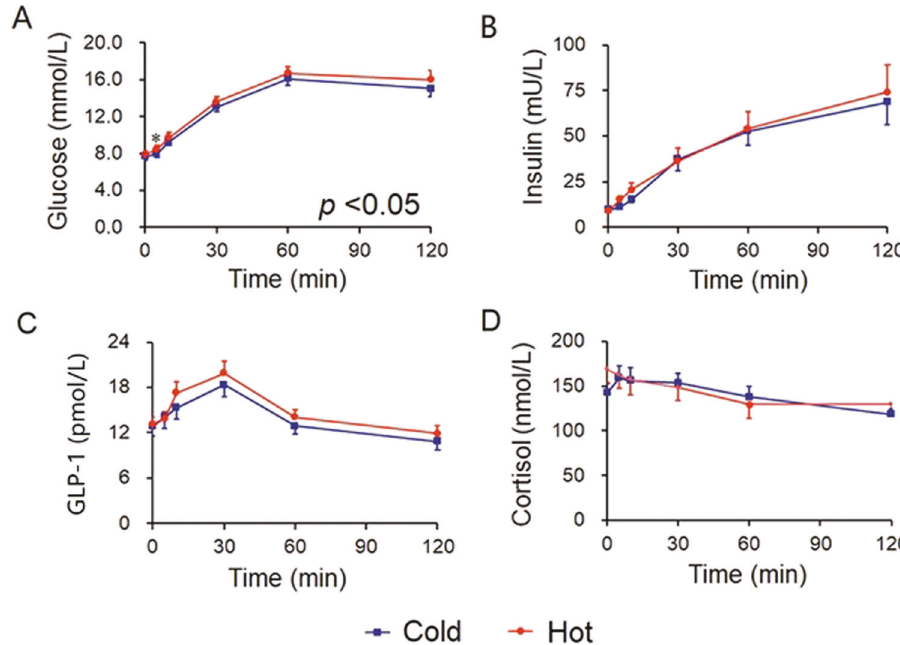
Fig. 2 The blood glucose and glucose-responsive hormone levels in cold and hot OGTTs in patients with T2DM. A Blood glucose, B insulin, C GLP-1, and D cortisol levels in OGTTs in patients with newly diagnosed treatment naïve T2DM ( n = 22). Data were analyzed with ANOVA for repeated measurements, and all “ P ” values are from the ANOVA. If there was statistical signi fi cance between the two temperatures ( P < 0.05), this was followed with a Bonferroni test for speci fi c time points. Blue line = cold OGTT; red line = hot OGTT; * P < 0.05 in Bonferroni test. OGTT oral glucose-tolerance test, GLP-1 glucagon-like